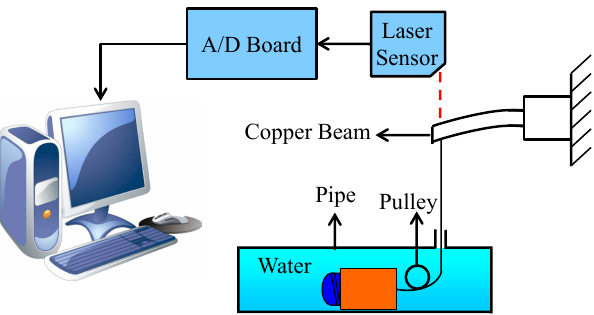
Figure 12. Schematic diagram of the measured propulsive force.